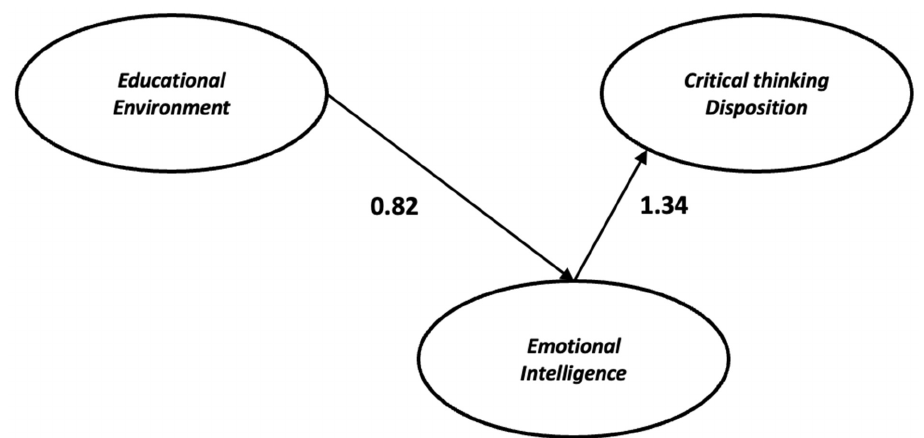
Figure 2. The effect of learning environment and emotional intelligence on critical thinking. Numbers next to the arrows are beta coefficients ( β ). Table 3. Regression analyses between Critical Thinking Disposition Scale (CTDS), Dundee Ready Education Environment Measure (DREEM), and Trait Emotional Intelligence Questionnaire Short Form (TEIQue-SF) .